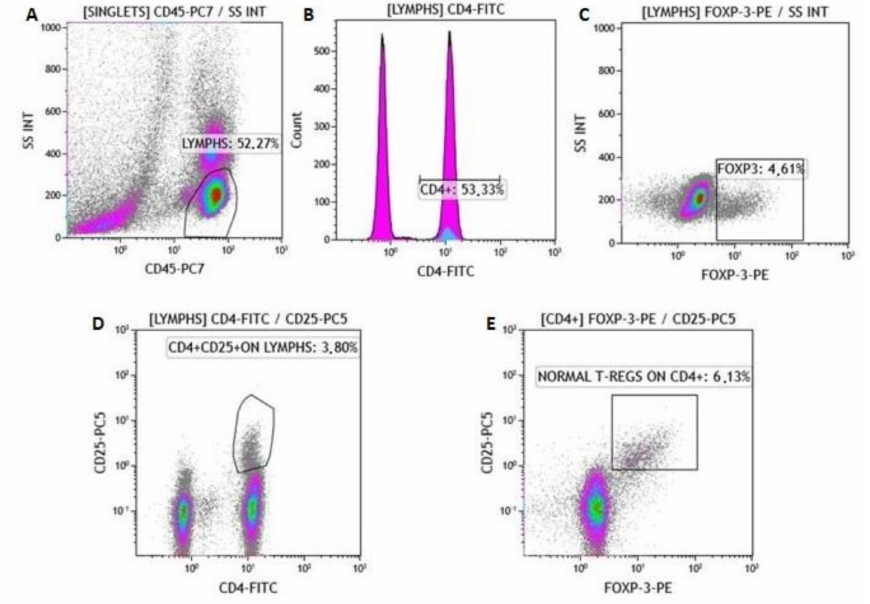
Figure 6. FOXP-3 assay—description of gating process. ( A ) Gating of lymphocytes. Identification of ( B ) CD4+, ( C ) FOXP-3 (+), and ( D ) CD4+CD25+ cells; ( E ) identification of normal Tregs on CD4+